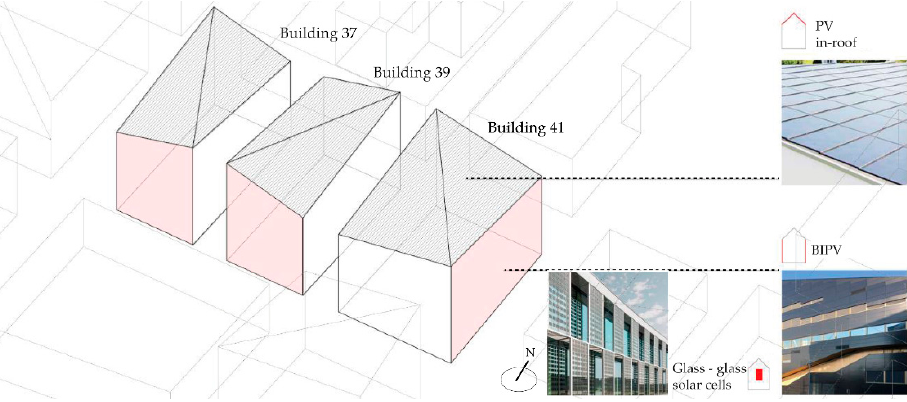
Figure 23. Solar technology recommendations for the critical area in feasibility study I.